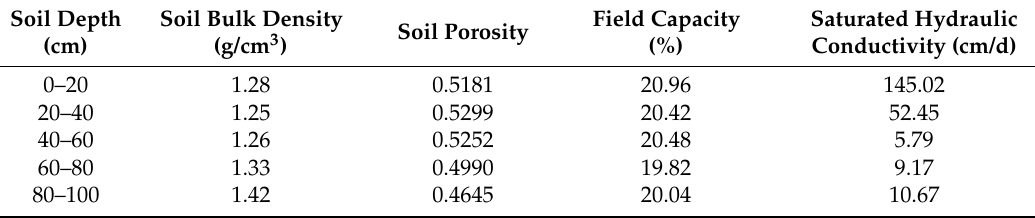
Table 2. Soil physical properties of the experimental area in the validation